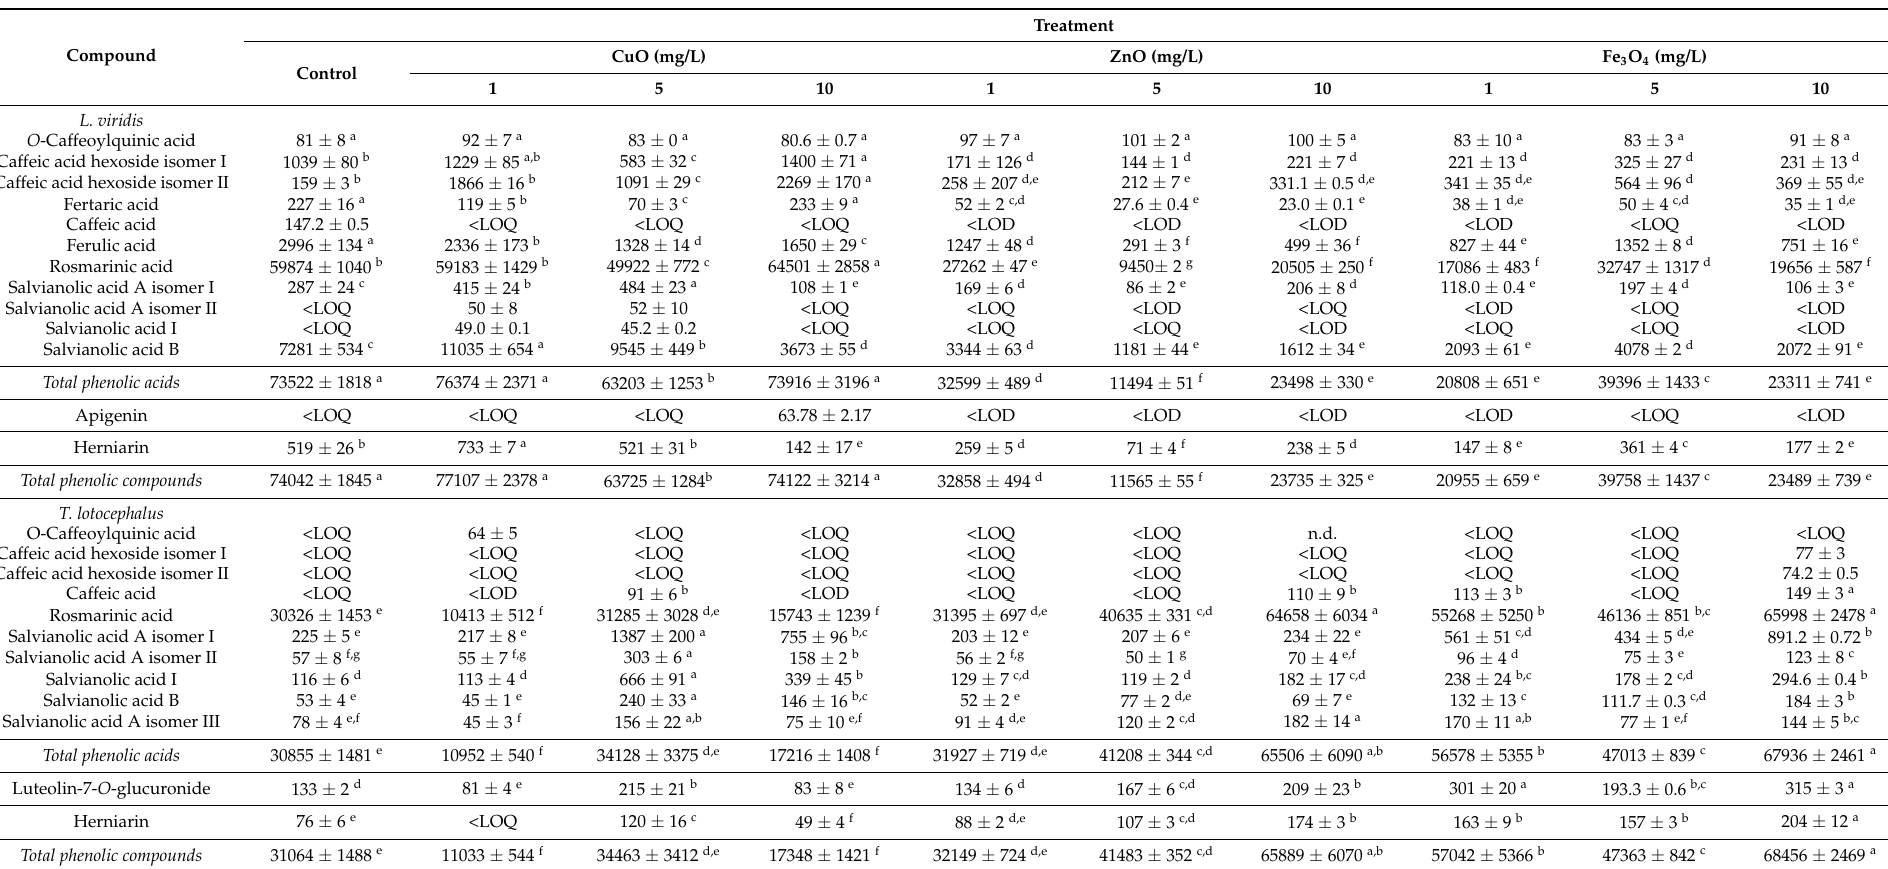
Table 2. Concentration (mg/kg of extract, mean ± standard error) of phenolic compounds present in the extracts from Lavandula viridis L’H é r and Thymus lotocephalus G. L ó pez and R. Morales shoots cultured in media with 0 (control), 1, 5 or 10 mg/L of CuO, ZnO and Fe 3 O 4